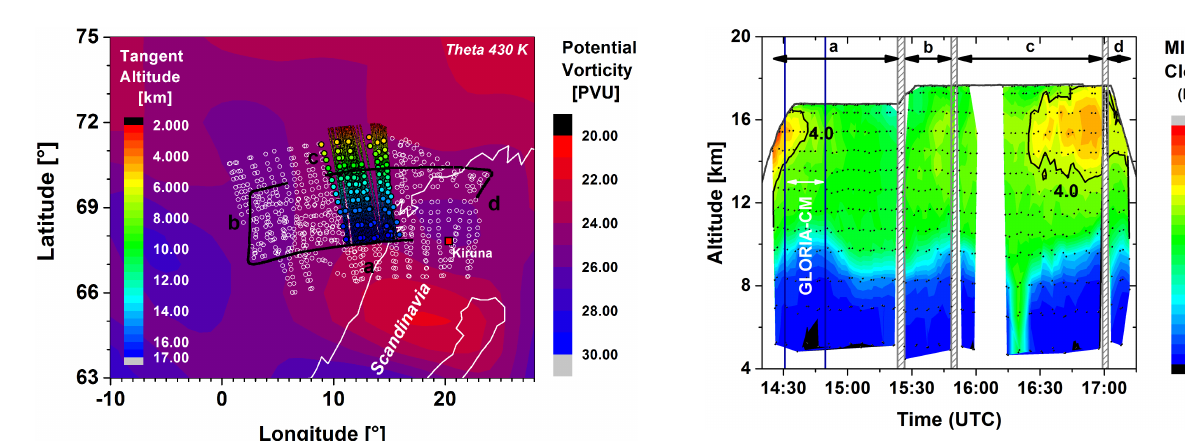
Figure 1. Flight path of the Geophysica (black line) during the flight on 16 December 2011. Tangent points of the MIPAS-STR observa- tions during the entire flight (open white circles) and observations selected for comparison with GLORIA (solid circles, color-coded with altitude). Tangent points of GLORIA observations (solid dots, color-coded with altitude). Contour: potential vorticity at the poten- tial temperature level of 430K (approximately 18km altitude).